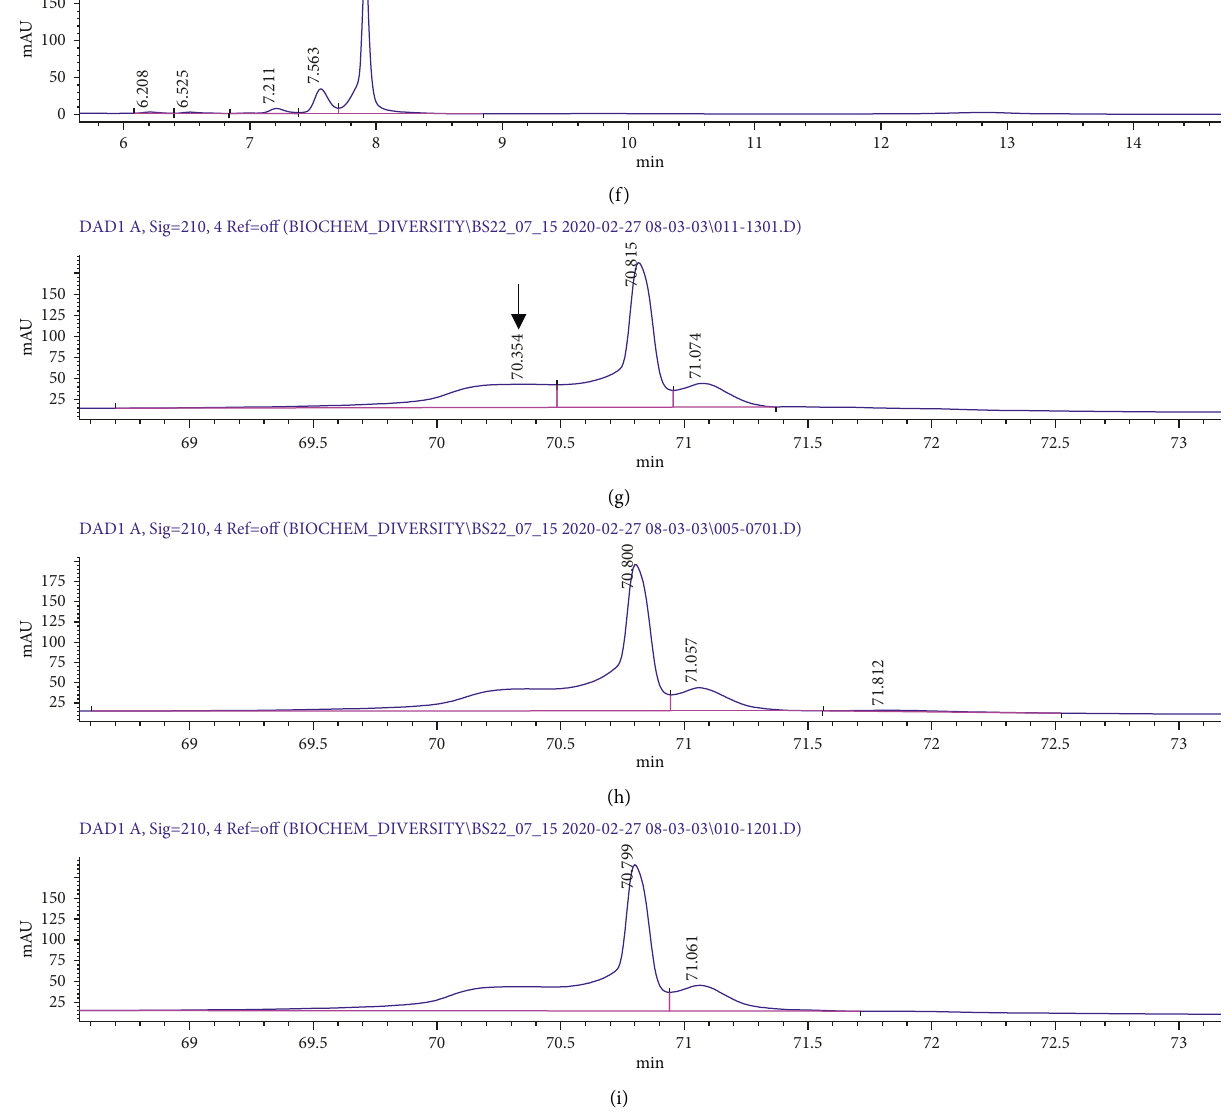
Figure 2: HPLC analyses of the bioactive coculture extracts together with their corresponding single culture extracts; A � 20-53, B � 20, C � 53, D � 53-90, E � 53, F � 90, G � 87-90, H � 87, I � 90; extra metabolite signals detected by the detector are indicated by